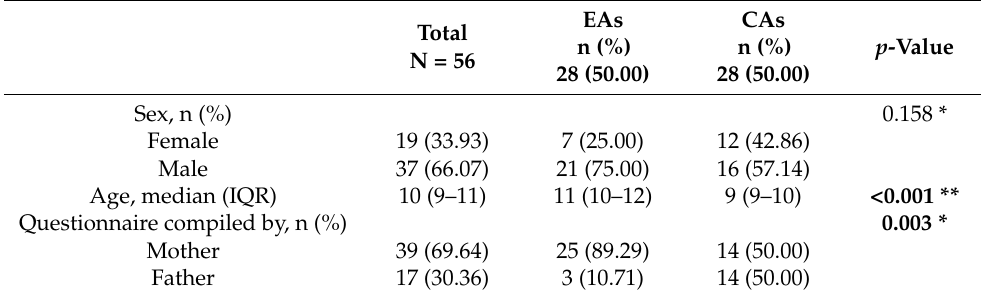
Table 1. Sociodemographic characteristics of respondents; EAs (Elastodontic Appliances), CAs (Clear Aligners).